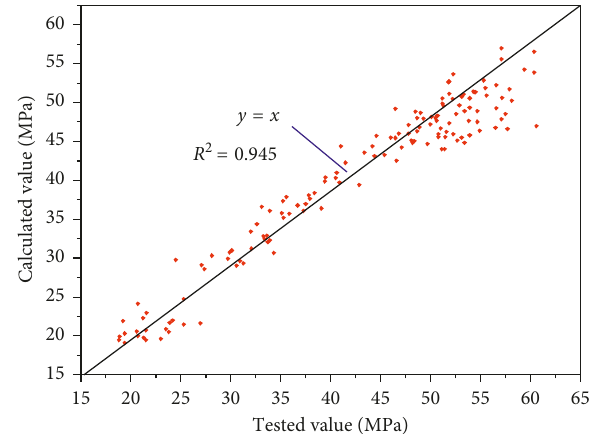
Figure 14: Comparison of calculated values and tested values of ( t ) f cu